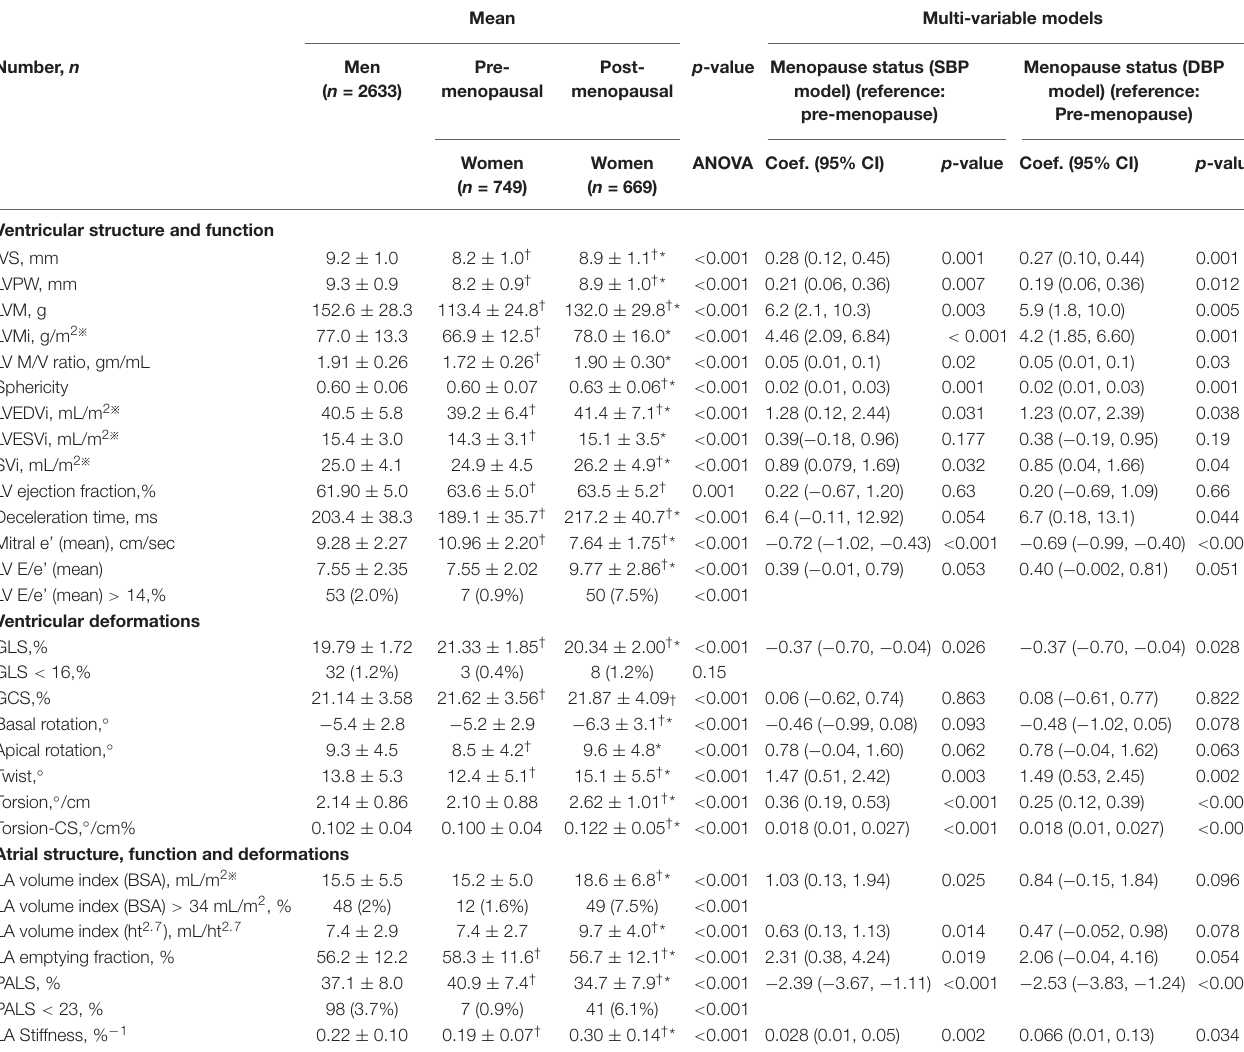
TABLE 2 | Sex differences and menopause relating to cardiac geometry, deformations and multivariable regression model.